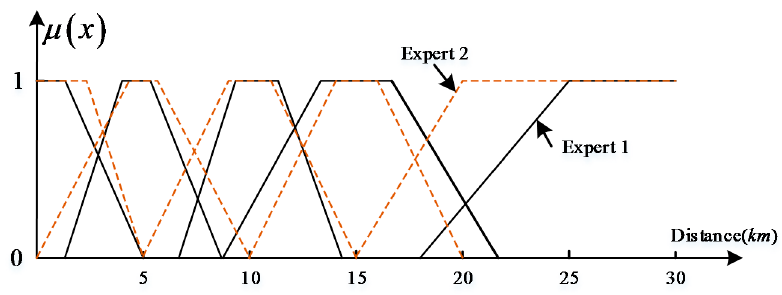
Figure 8. Type-1 fuzzy sets modeling for distance words corresponding to two experts.